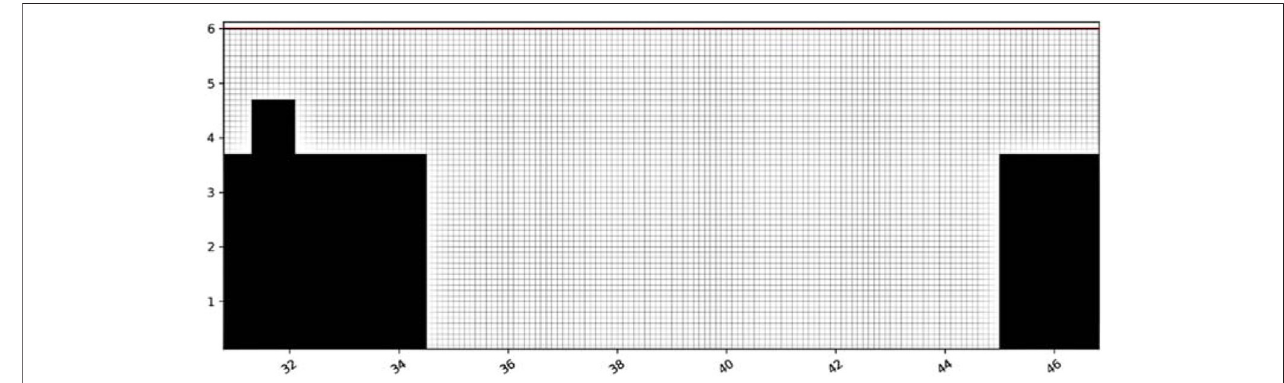
FIGURE 2 | Geometry model and mesh of the RUT facility.